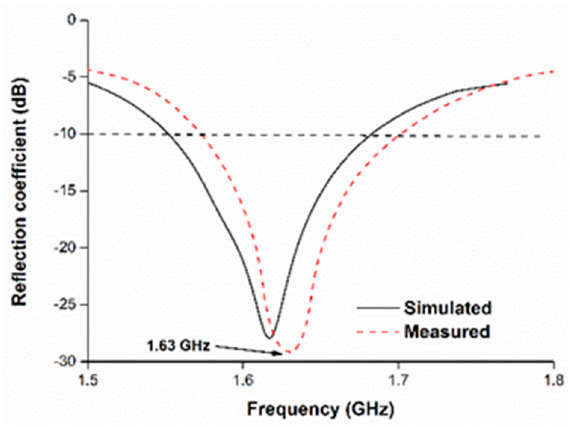
Figure 3. Reflection coefficients of the proposed antenna.